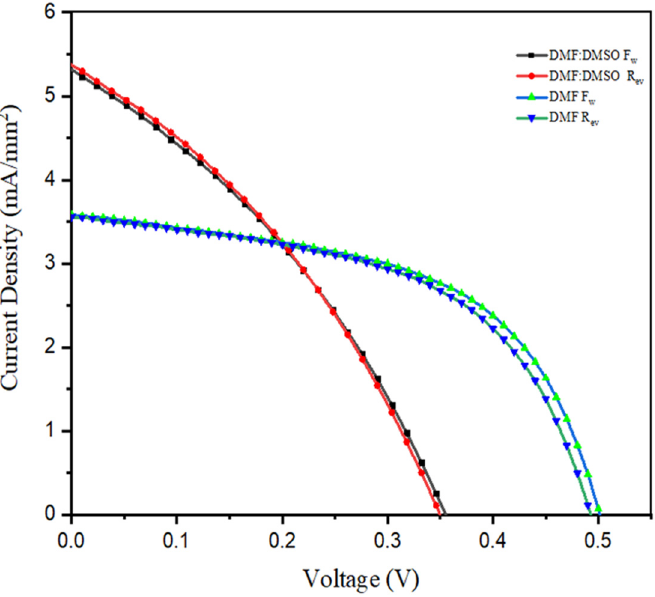
Materials 2022 , 15 , x FOR PEER REVIEW Figure 3. The influence of precursor solvent in open-circuit voltage and current density.